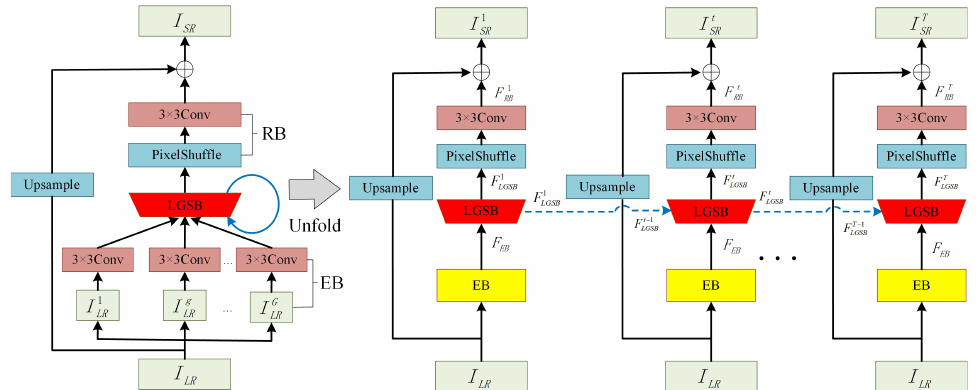
Figure 1. The overview of our proposed Feedback Refined Local-Global Network (FRLGN). The blue arrows are the feedback connections and the Local-Global Spectral Block (LGSB) represented by the trapezoidal block is specifically designed for the task of super-resolution of hyperspectral